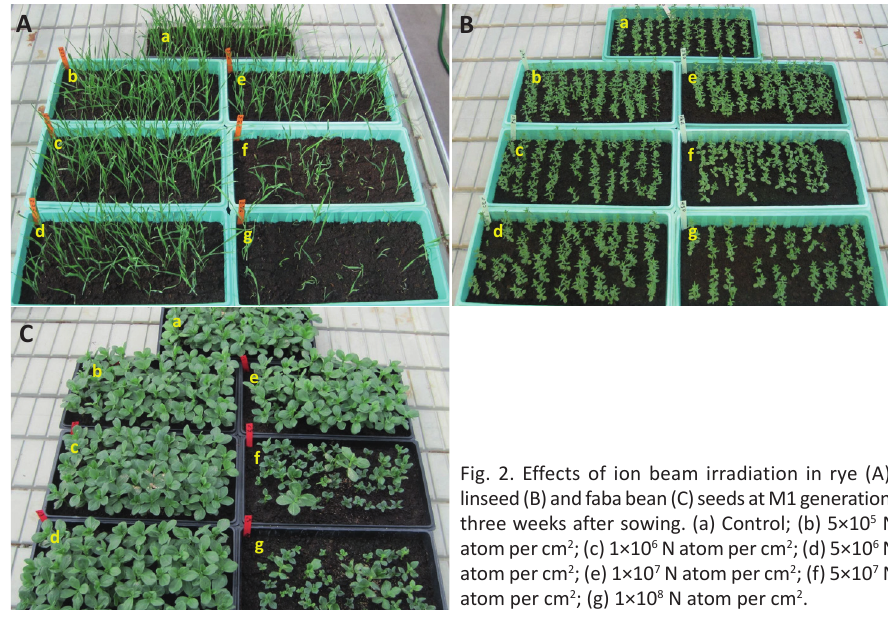
Fig. 2. Effects of ion beam irradiation in rye (A), linseed (B) and faba bean (C) seeds at M1 generation, three weeks after sowing. (a) Control; (b) 5×10 5 N atom per cm 2 ; (c) 1×10 6 N atom per cm 2 ; (d) 5×10 6 N atom per cm 2 ; (e) 1×10 7 N atom per cm 2 ; (f) 5×10 7 N atom per cm 2 ; (g) 1×10 8 N atom per cm 2